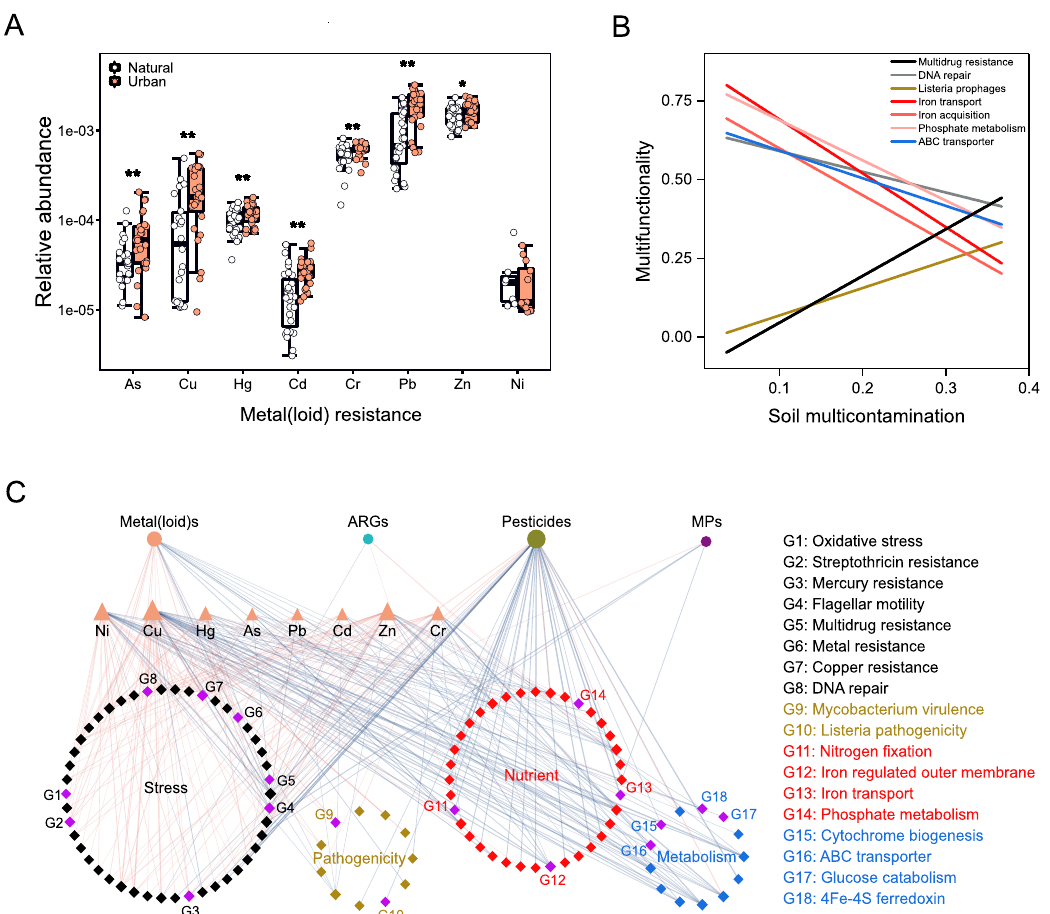
Fig. 3 | Associations between soil contaminants and functional soil micro- biome.A proportionsofthegenesassociatedwithmetal(loid)resistance.Asterisks indicate signi fi cant differences between urban and natural ecosystems according to nested PERMANOVA using a block design as described in the Method section. * P <0.05; ** P <0.01. Detailed statistical results for the PERMANOVA are shown in Supplementary Table 8. B the fi tted linear relationships between multi- contamination (standardized between 0 and 1, see Methods) and proportions of the selected functional genes, which are related to stress resistance (black),